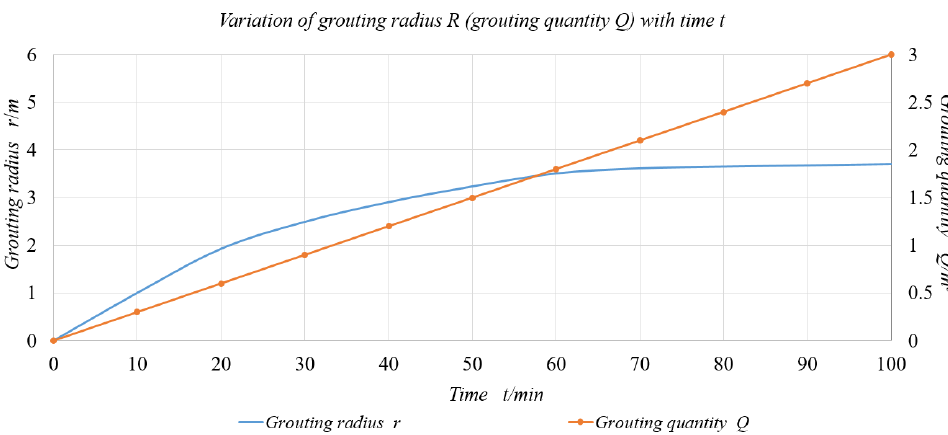
Figure 9. Variation in diffusion radius R (grouting quantity Q ) with time t.